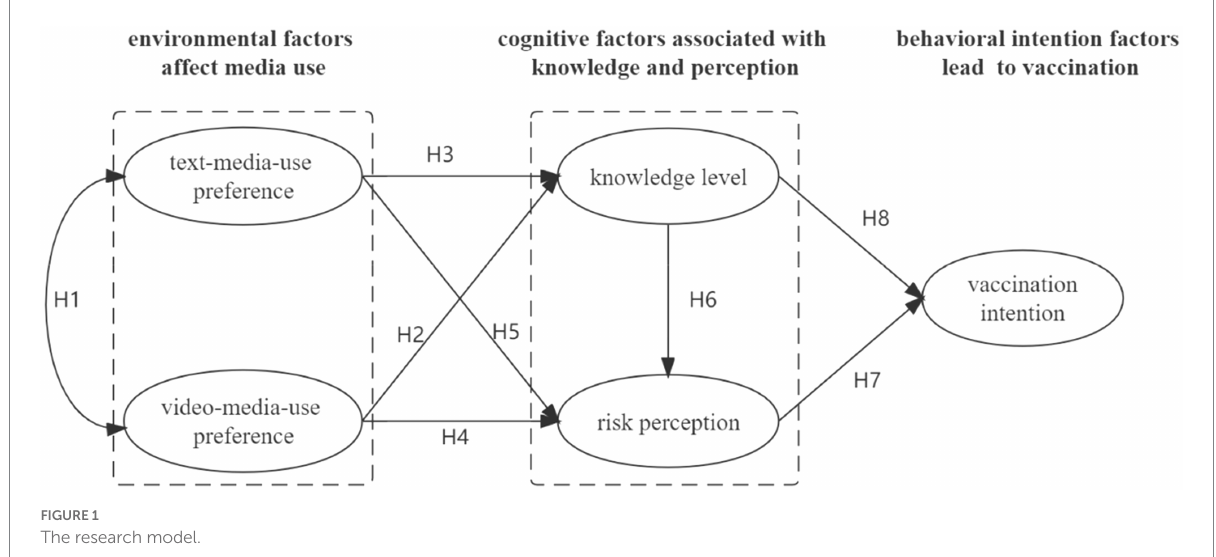
FIGURE 1 The research model.